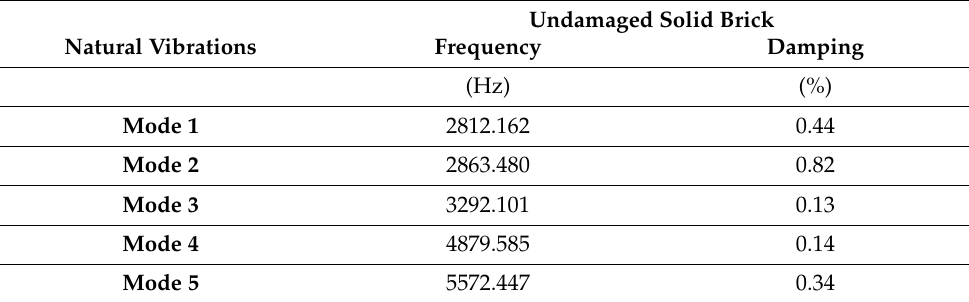
Table 2. List of natural frequencies and damping coefficients for undamaged solid ceramic brick. Undamaged Solid Brick